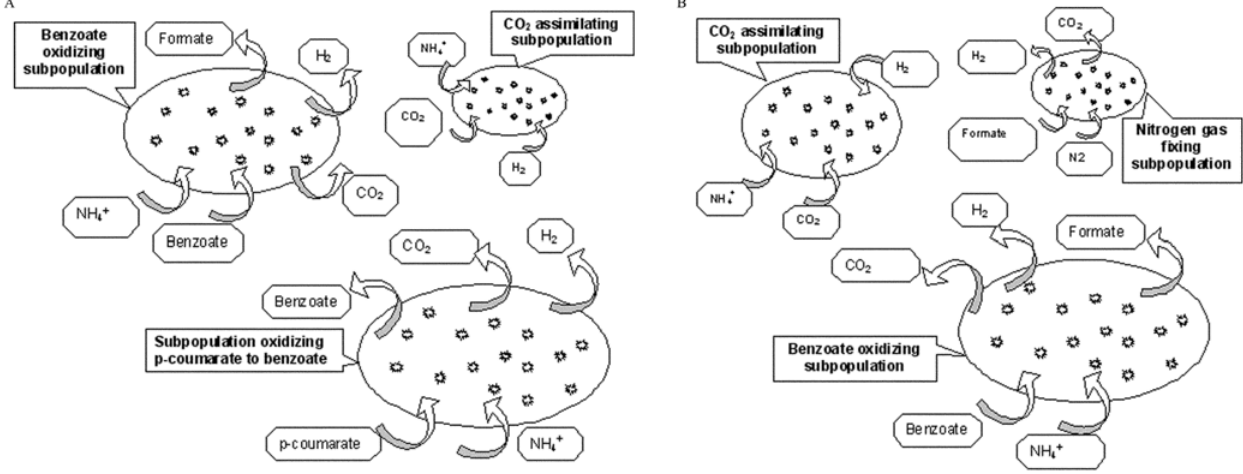
Figure 2. Structures of R. palustris consortia mediating anaerobic growth on p-coumarate (A) and on benzoate (B).